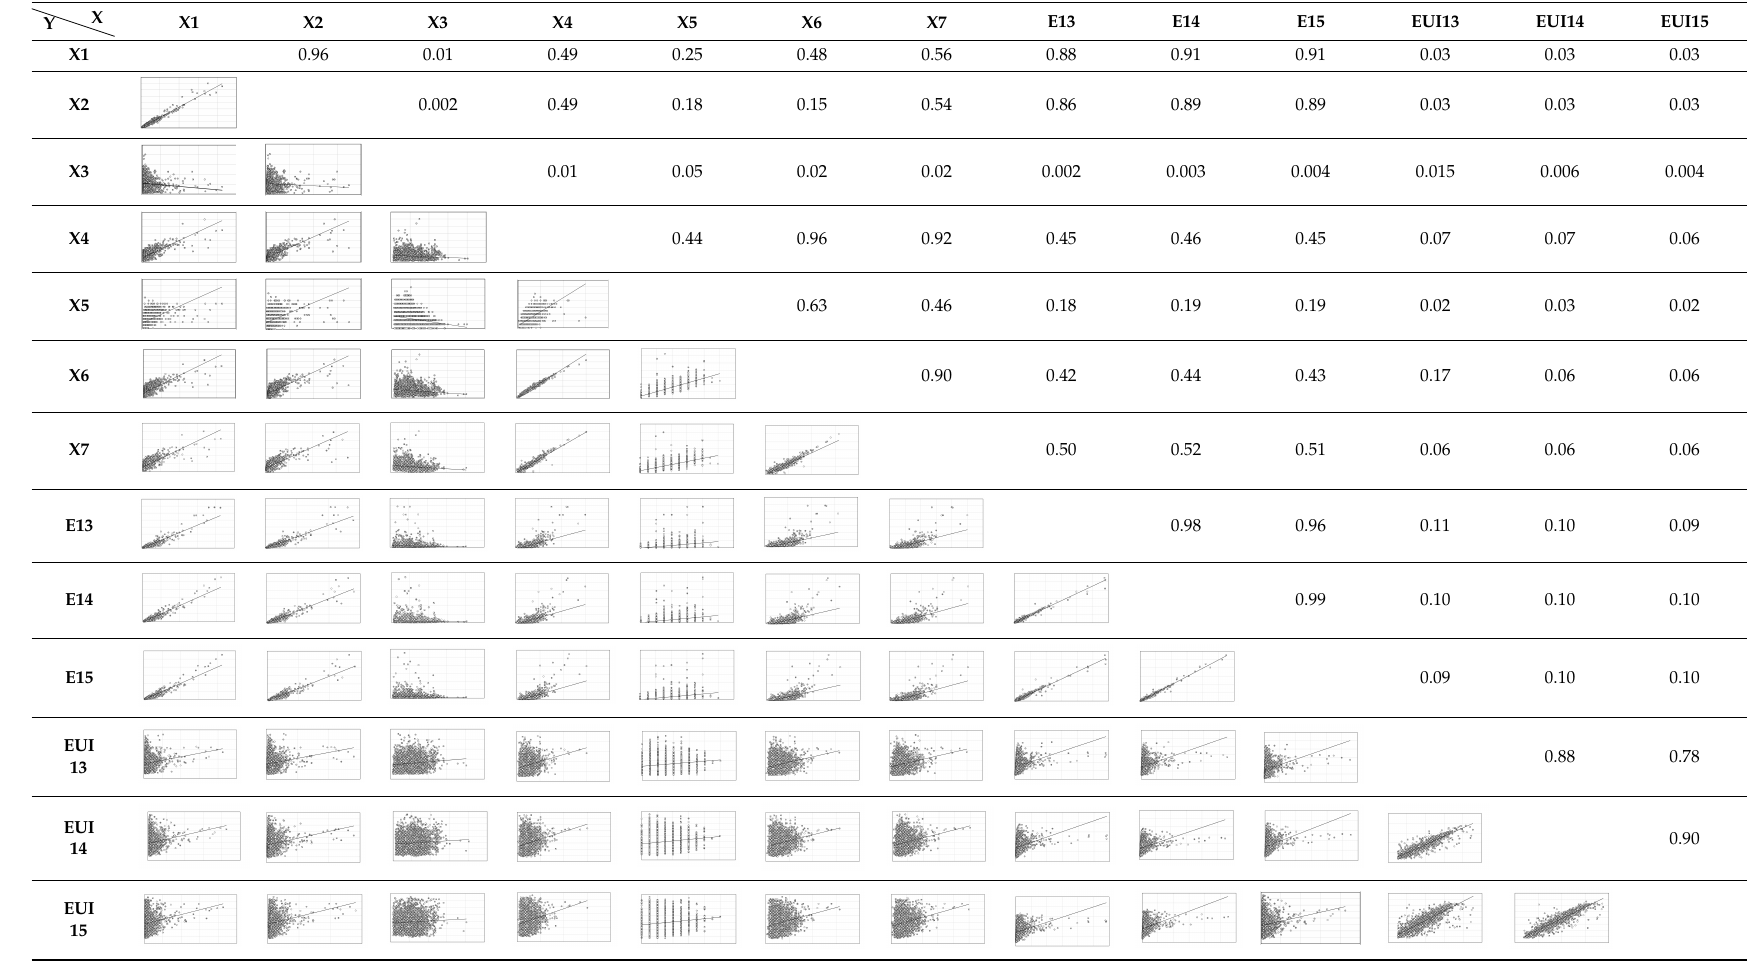
Table 4. Graphs and determination coe ffi cients of simple linear regression analysis between